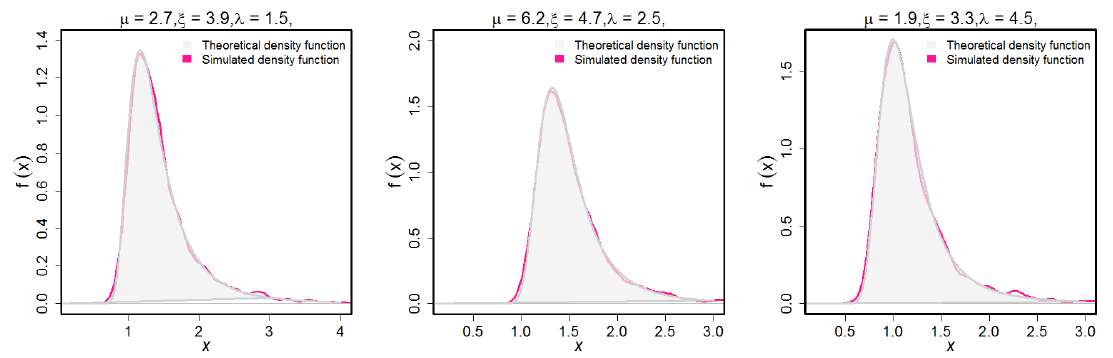
Fig. 3. Simulated model for parametric set I to III : Figure 3. Simulated model for a parametric set I to III. The bias gradually decreases until it reaches zero as n rises, we thus conclude that estimators have an asymptotic unbiasedness property. The MSE trend, on the other hand, implies consistency as the error approaches zero as n increases.